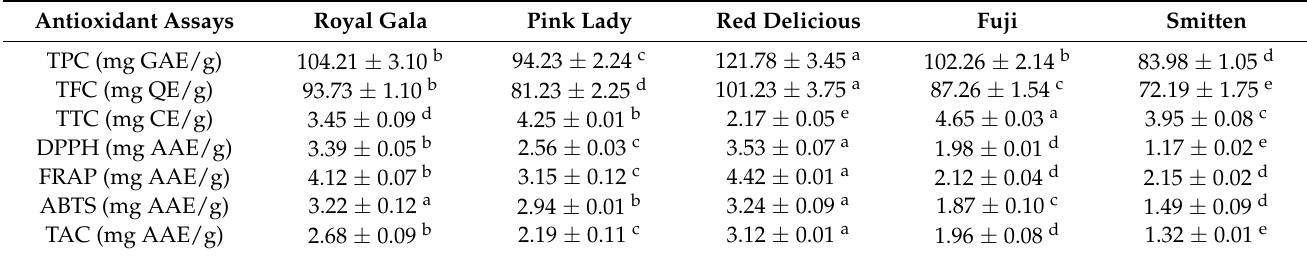
Table 1. Phenolic content and antioxidant potential in five varieties of